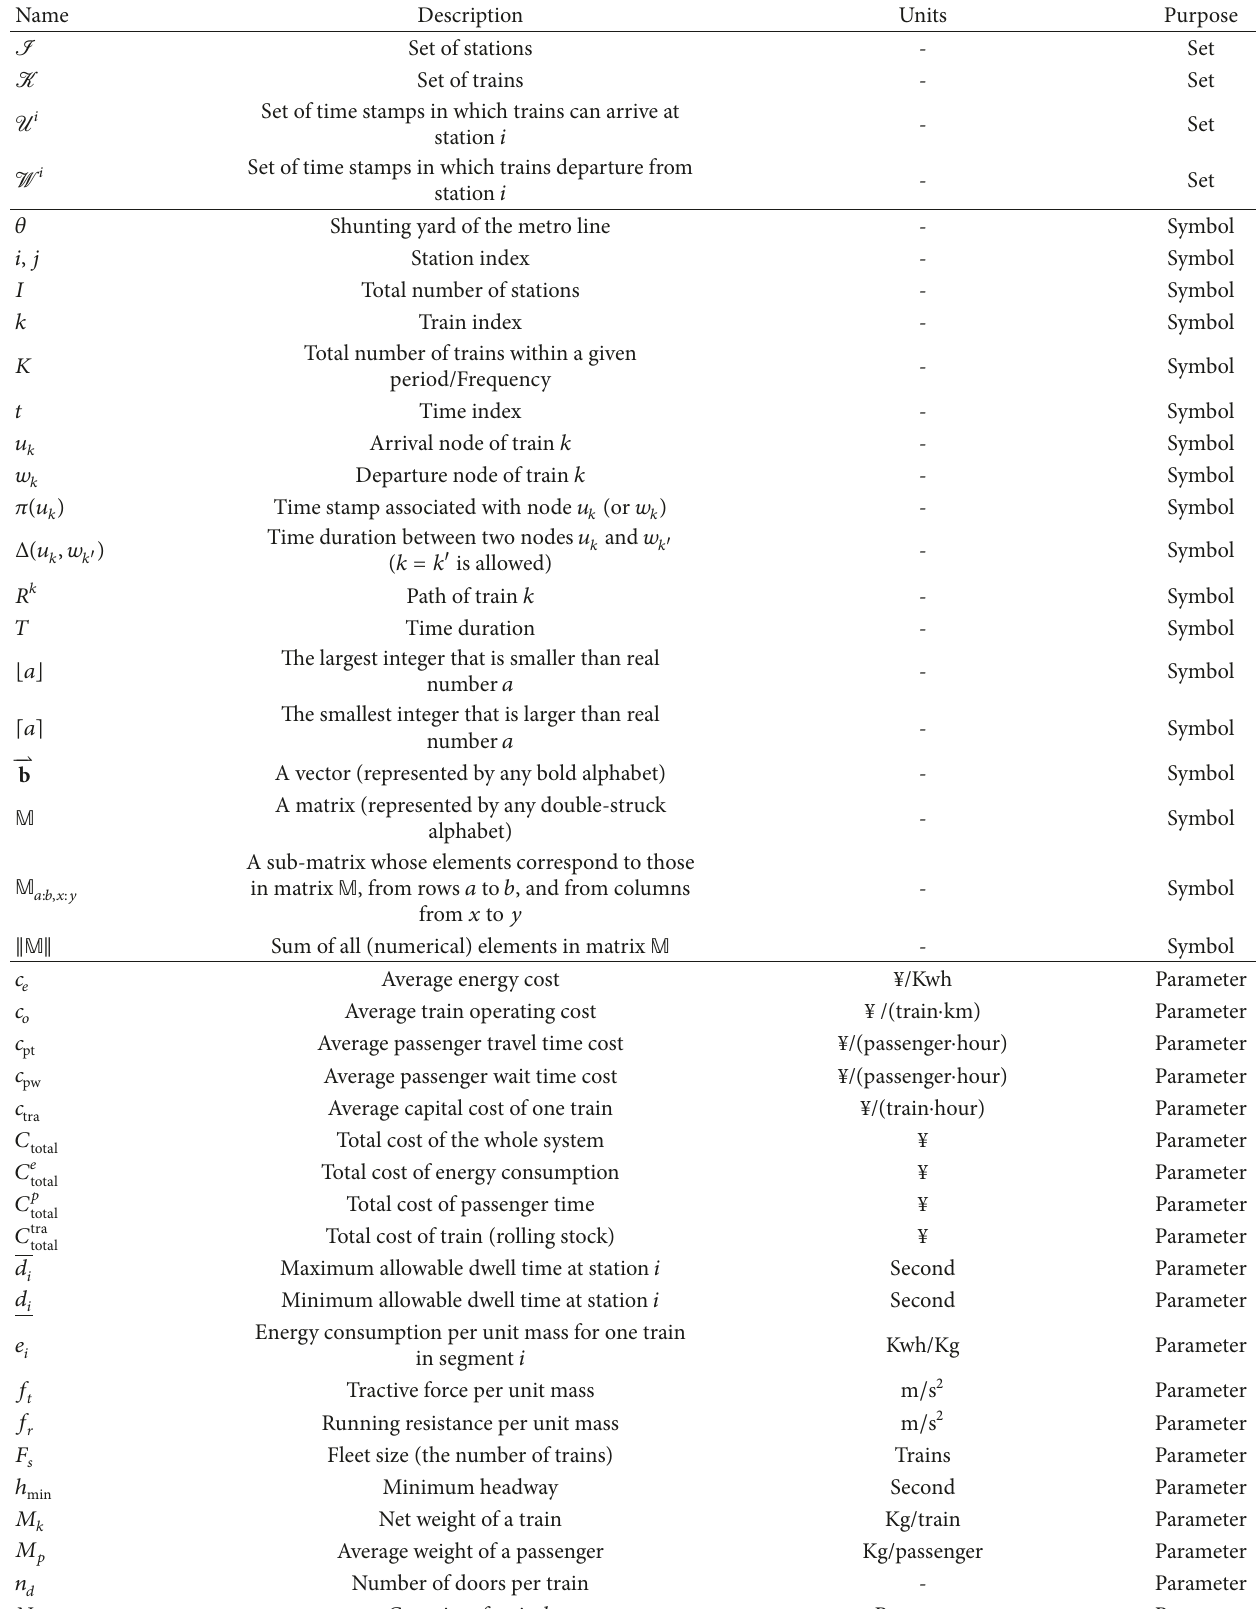
Table 2: Parameters and